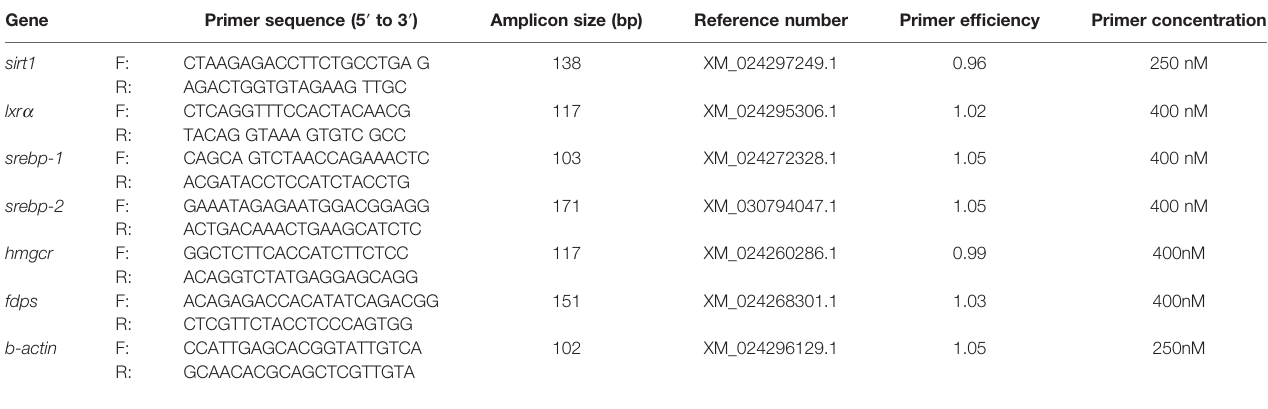
TABLE 1 | Primer sequences used for the cDNA cloning (PCR) and expression detection (qPCR) of medaka livers. Gene Primer sequence (5 ′ to 3 ′